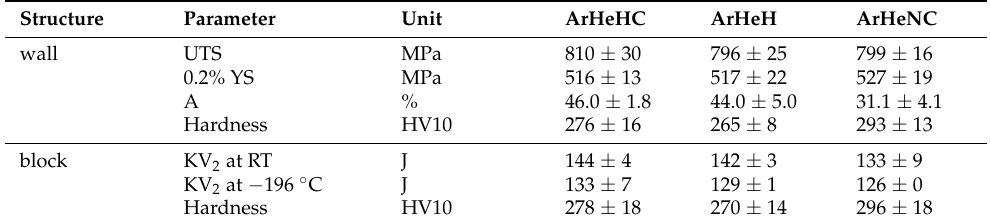
Table 6. Mechanical properties of wall and block parts of HY282 ( Φ 0.035 ″ ) depending on shielding gas.